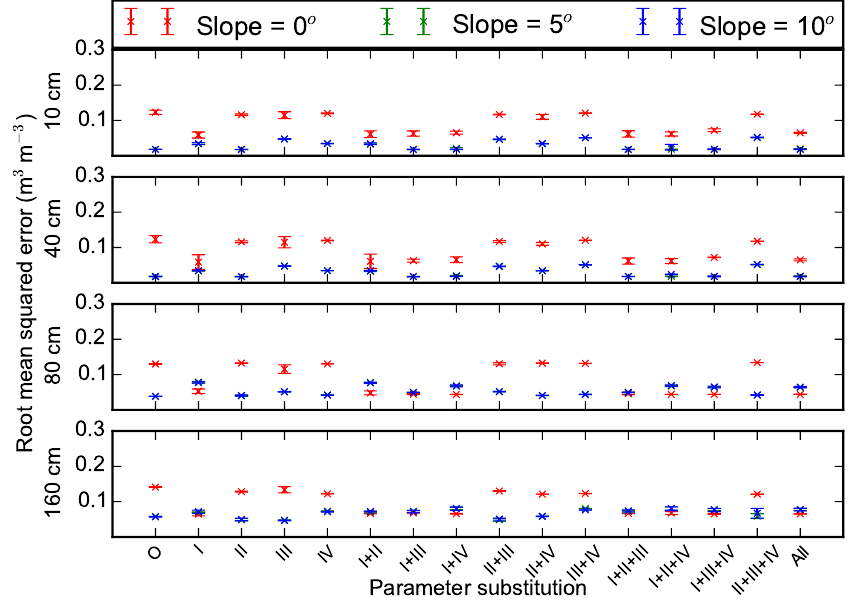
Figure 11. Root mean square errors between measurements and model simulations (with different combinations of measured porosity (I), thermal conductivity (II), hydraulic conductivity (III), and matric potential (IV) substituted for default sand parameters) for 10, 40, 80, and 160cm soil volumetric liquid water content. O and All represent model runs without substitution of default parameters and with all four parameters substituted. Mean and standard deviation of model simulations with three different soil thicknesses at each slope (0, 5, and 10 ◦ ) are shown.